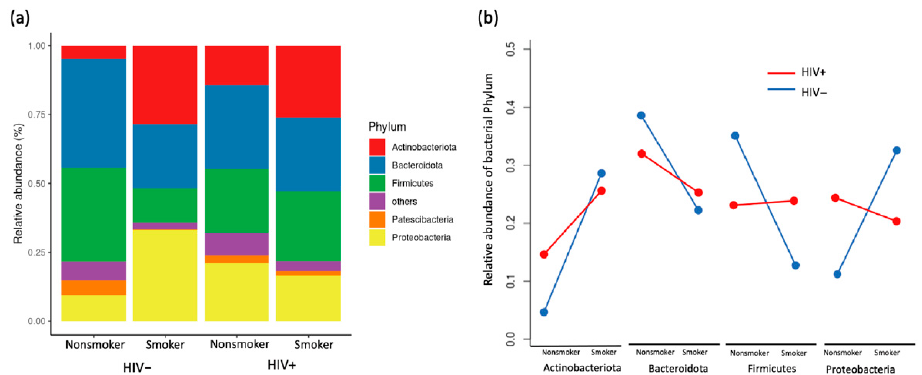
Figure 2. The composition of lung bacterial phyla ( a ) and the response of major phyla to smoking ( b ) for PLWH and Non-HIV samples.